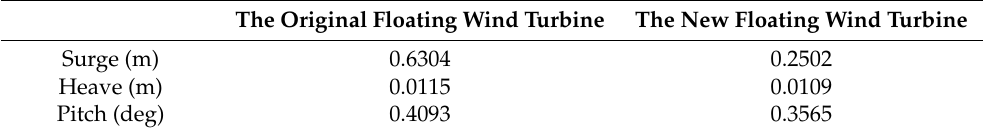
Table 10. RMS of responses to two types of wind turbine under normal operating condition.